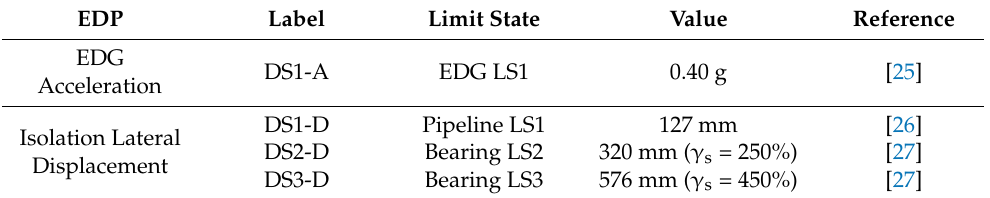
Table 1. Limit states and HCLPF values per